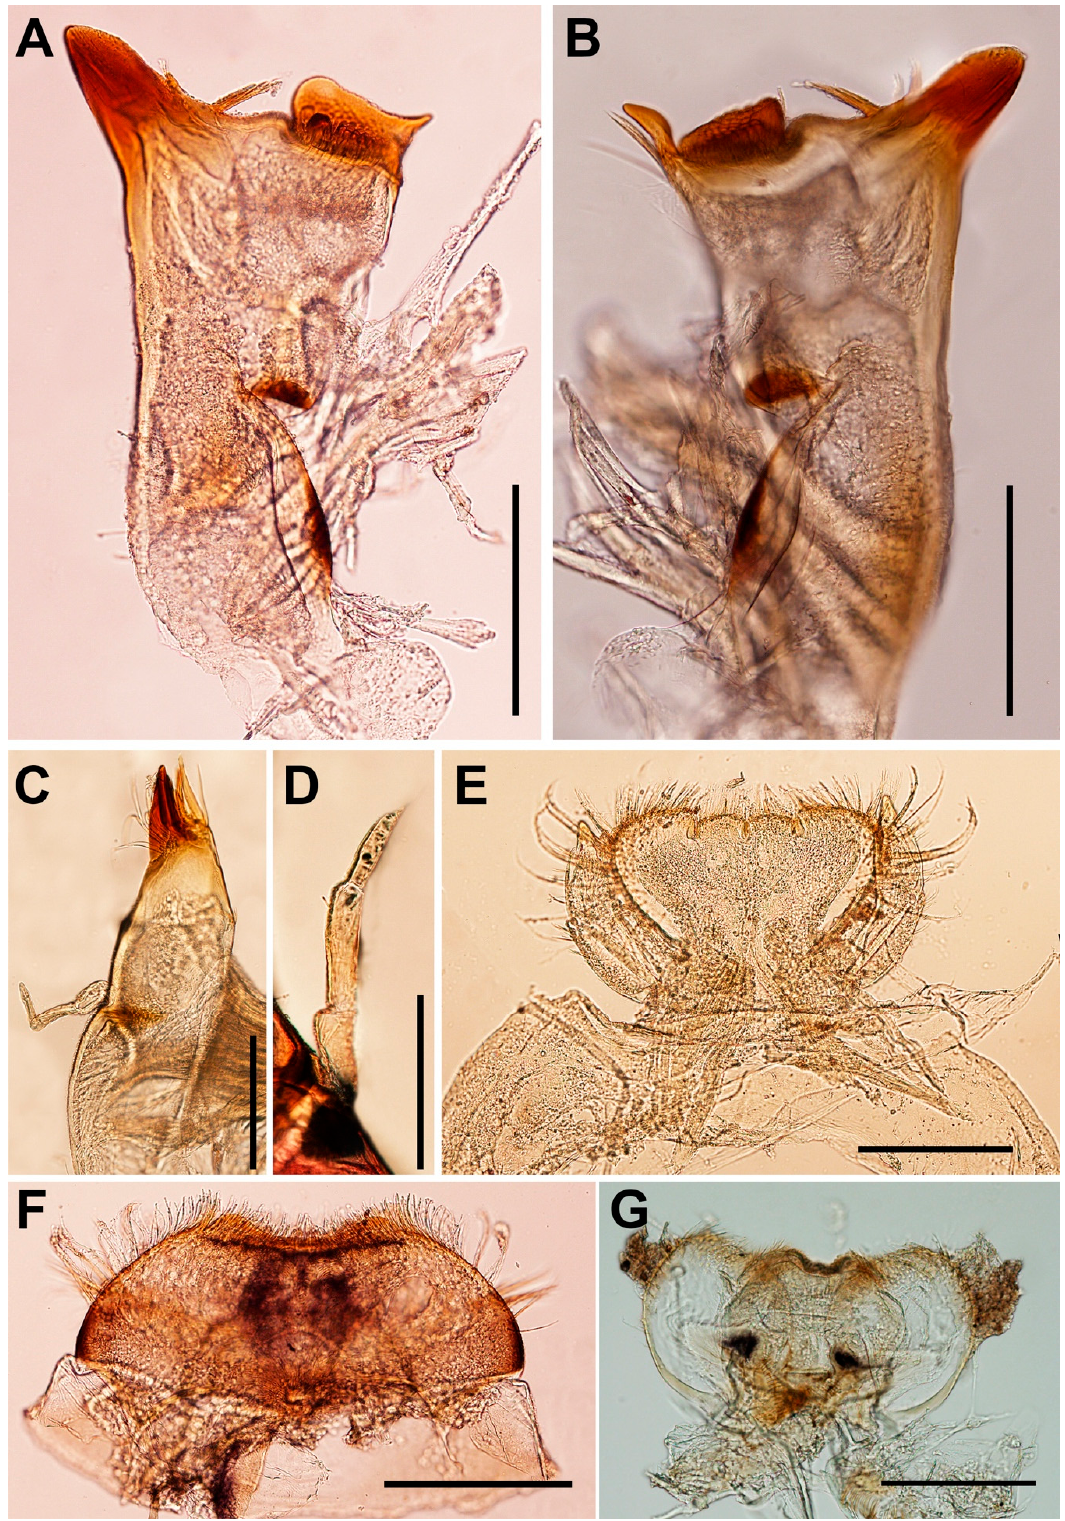
Figure 2. Vietnamella nanensis sp. n. ( A ) left mandible; ( B ) right mandible; ( C ) maxilla; ( D ) maxillary palp; ( E ) labium; ( F ) labrum; ( G ) hypopharynx. Scale bars: 0.2 mm.